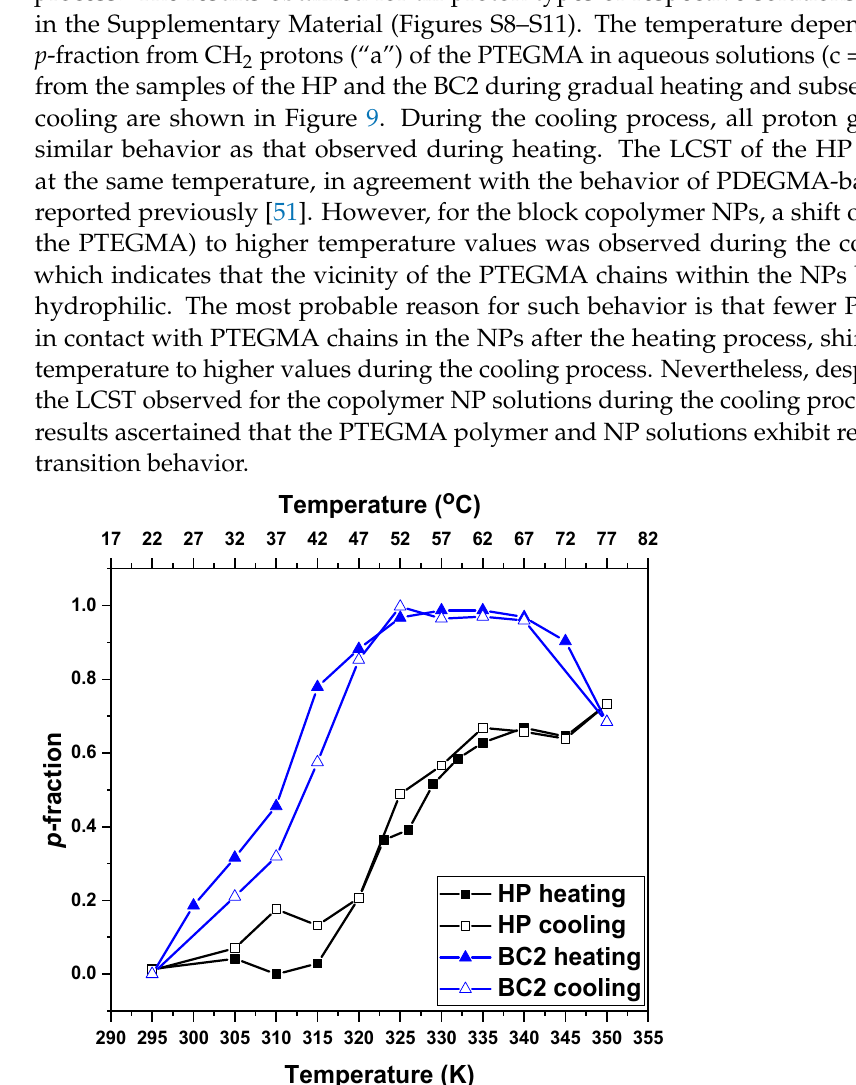
Figure 9. Temperature dependencies of the p - fraction for the PTEGMA CH 2 protons (signal “a”) in D 2 O solutions (c = 2.5 mg · mL − 1 ) of HP and BC2 NPs determined during gradual heating and subsequent gradual cooling.